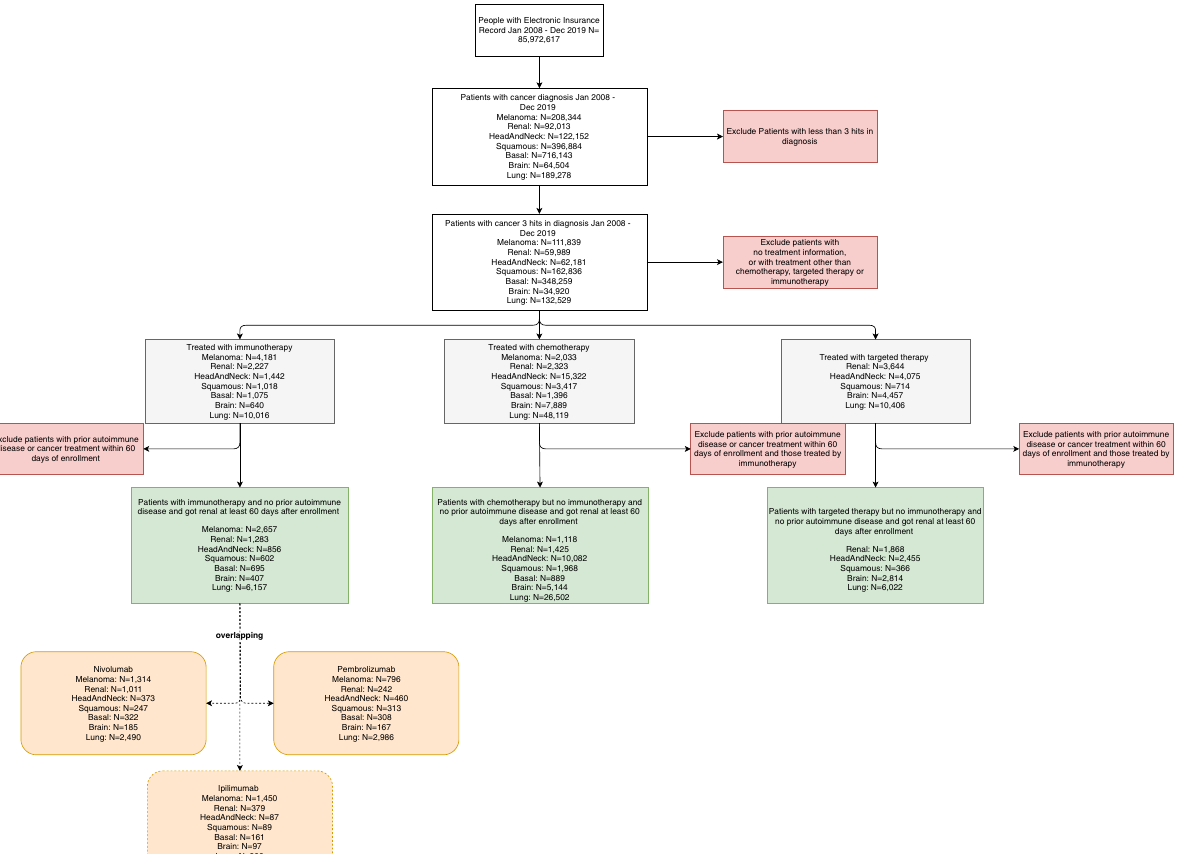
Fig. 1 A summary of the patient cohorts in our study. The numbers of patients at each stage of cohort derivation were shown. The detailed inclusion and exclusion criteria can be found in the Methods section. Table 1. Patient characteristics of the immunotherapy and chemotherapy groups in the renal cancer cohort. Demographic